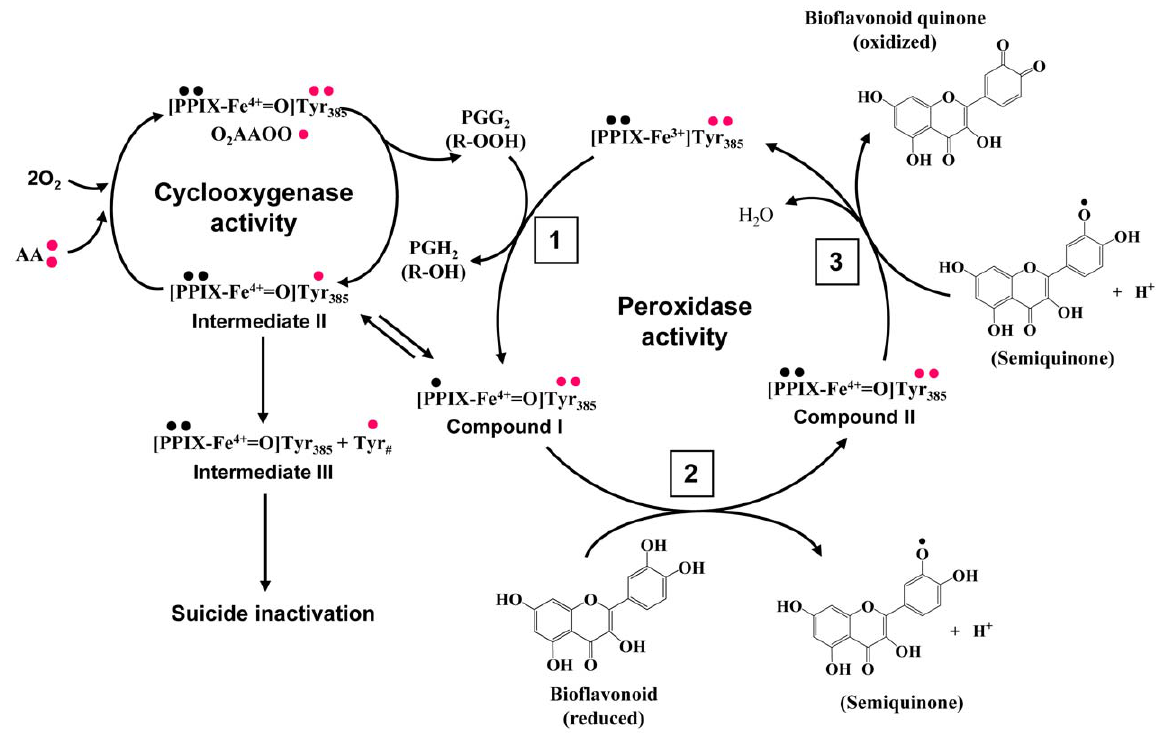
Figure 6. Schematic depiction of the catalysis and inactivation mechanism of COX enzymes and their interaction with bioflavonoids. PPIX is for protoporphorin IX. Quercetin structure is shown as a representative bioactive bioflavonoid. Events in the peroxidase cycle are labeled with numbers to denote the sequence of occurrence.